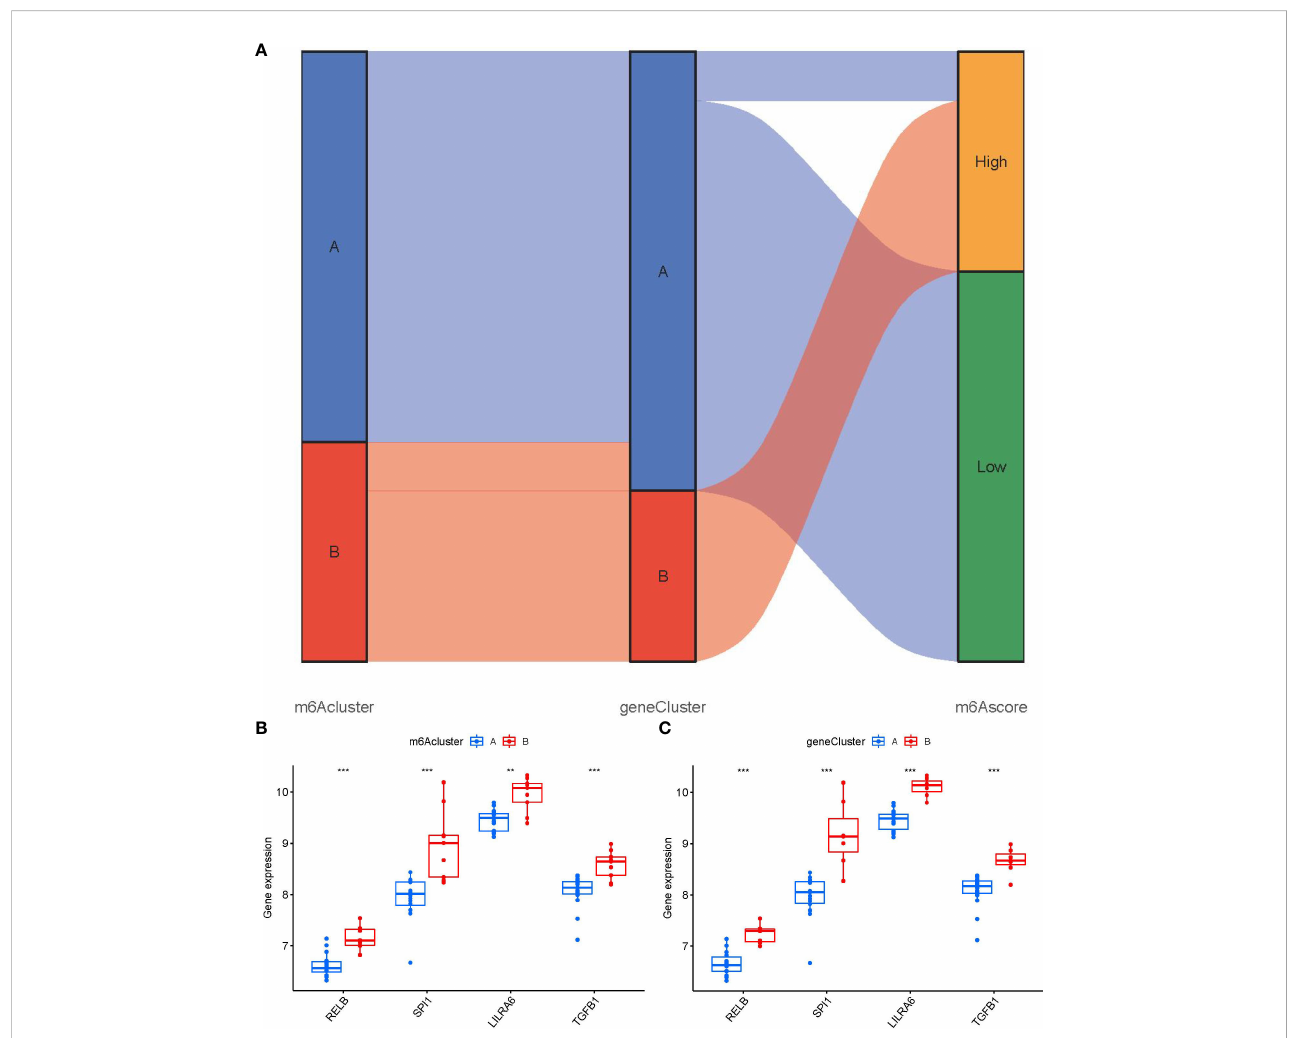
FIGURE 9 Role of m6A patterns in distinguishing PMOP. (A) Sankey diagram showing the relationship between m6A patterns, m6A gene patterns, and m6A scores. (B) Differential expression levels of osteoclast differentiation-related genes between clusterA and clusterB. (C) Differential expression levels of osteoclast differentiation-related genes between gene clusterA and gene clusterB. **p < 0.01, and ***p < 0.001.